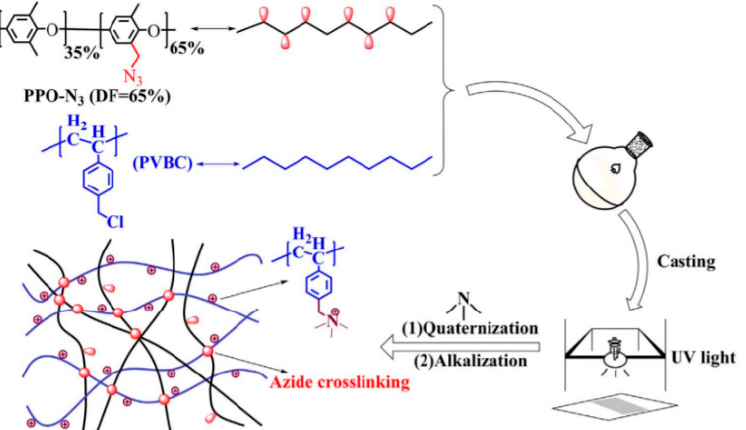
Figure 2. Crosslinking of PVBC-based AEMs with PPO-N 3 by solution casting and UV irradiation methods. Reprinted with permission from [47] . Copyright Elsevier, 2017.